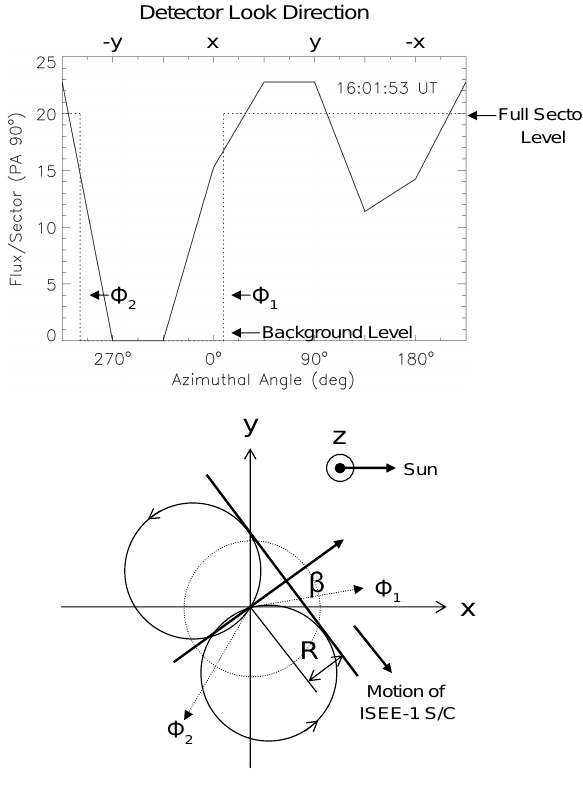
Fig. 6. The top plot shows the flux per sector for the 16:01:53 UT record, where there is an absense of particles at a range of azimuthal angles becauce the s/c is too far away from the CDC boundary to observe particles with those gyroradii. These angles are used to find the orientation angle β , measured from the x-axis, and the distance R of the boundary from the s/c (bottom). This method is used for Figs. 7–8.